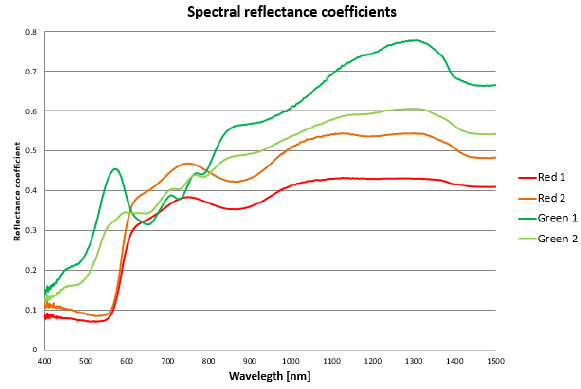
Figure 10. Segment no 3: Spectral reflectance coefficients of various paints 4. PRELIMINARY